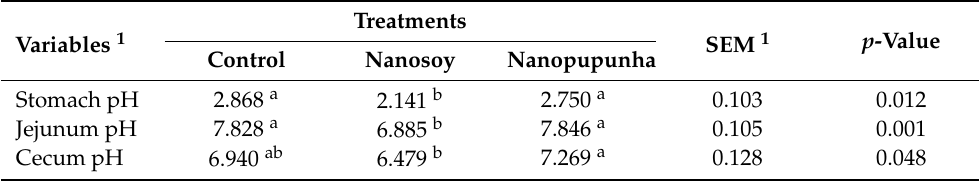
Table 4. Mean pH values of the digestive tract contents obtained from growing rabbits fed different sources of nanofibers and those fed a control